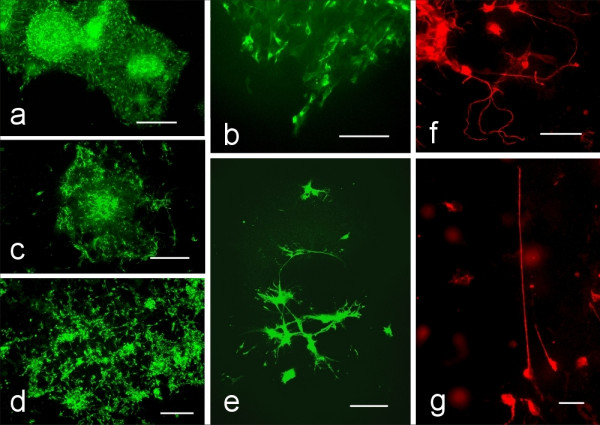
Neurite length of differentiated neurons (identified by b-III tubulin immunocytochemistry) grown on laminin coated glass coverslips. The data (average of all neurites ±SEM) show a significant increase in neurite outgrowth from the PTPs(-/-) mice (KO) relative to sibling (Sib) controls. Data represent 4 separate experiments with a total of 469 neurites measured for the knockout mice and 573 neurites for the siblings. KO represents mice genotyped as PTPs (-/-) and Sib represents mice genotyped as PTPs(+/-) or PTPs (+/+).  There was no difference in the length of neurites between the neurons from the PTPs(+/+) or (+/-) neurospheres, hence their data were combined.